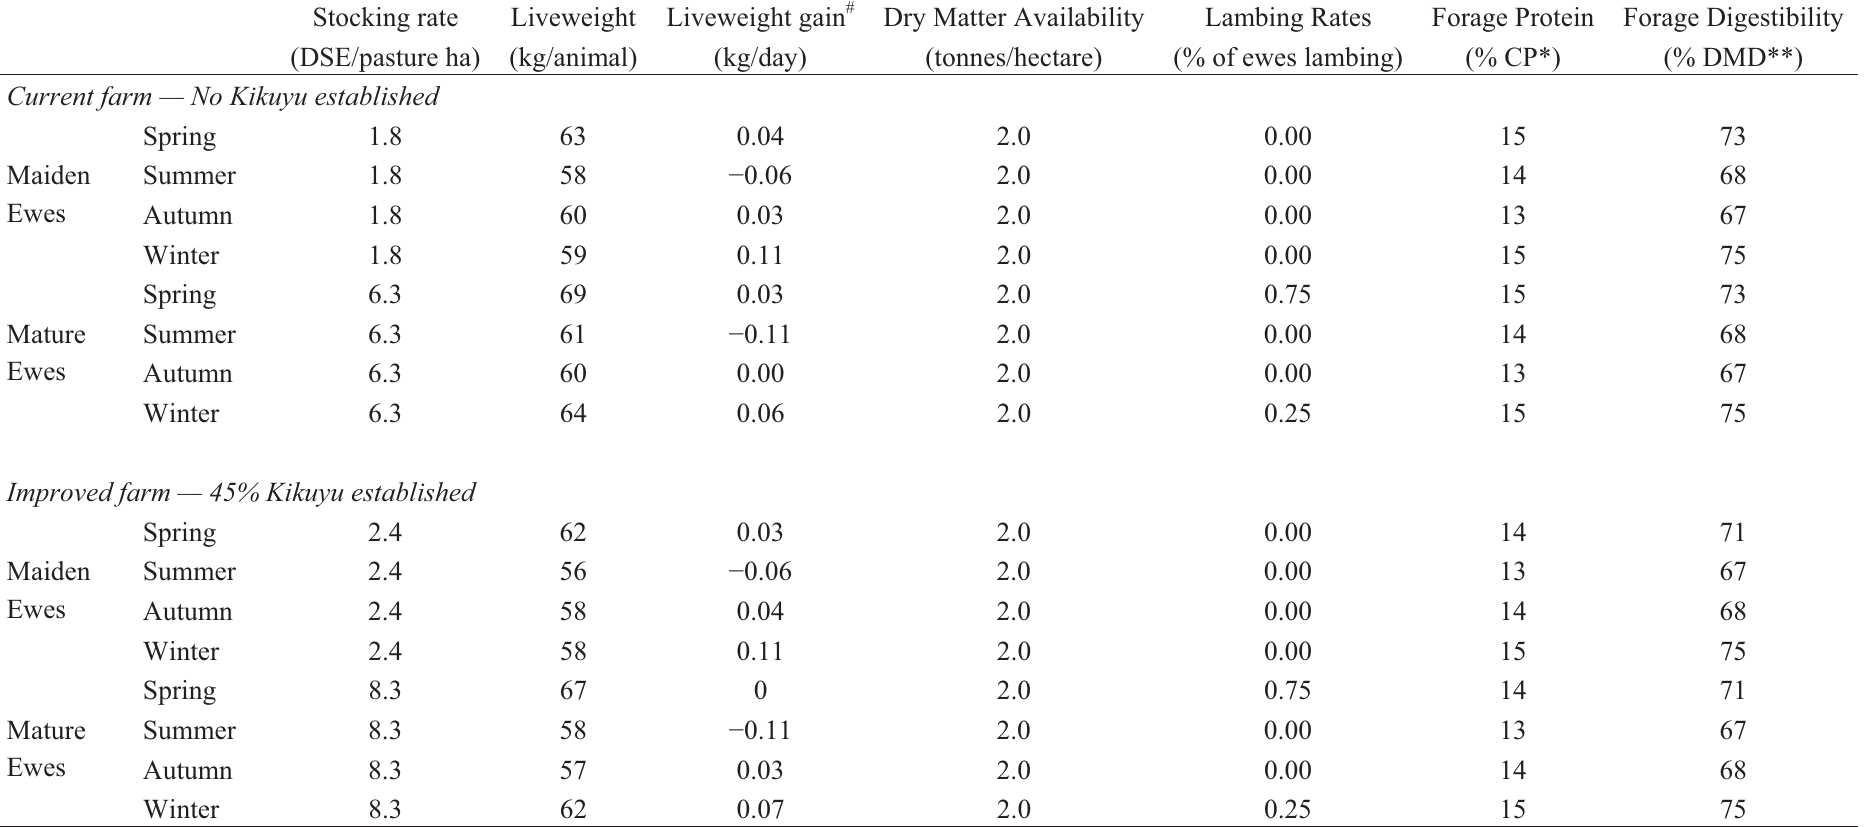
Table 1. Biophysical values used as input values for the Sheep Greenhouse Accounting Framework for both Current and Improved farms taken from the GrassGro simulation